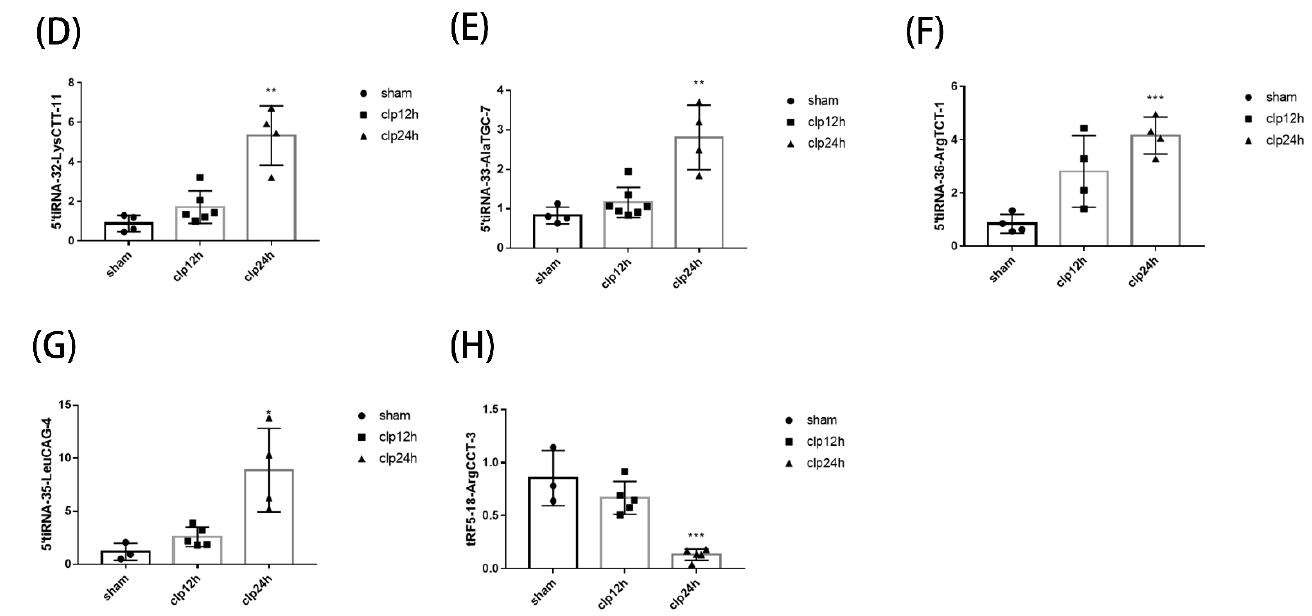
Figure 3. Identification of septic cardiomyopathy-related tsRNAs and qPCR verification. ( A – H ) The qPCR results confirmed that 5 ’ tiRNA-34-AspGTC-2( n = 4 in SHAM group, n = 7 in CLP12h group, n = 3 in CLP 24h group) 、 5 ’ tiRNA-33-CysACA-1( n = 4 in SHAM group, n = 3 in CLP12h group, n = 3 in CLP 24h group) 、 5 ’ tiRNA-33-ProTGG-1( n = 3 in SHAM group, n = 4 in CLP12h group, n = 4 in CLP 24h group) 、 5 ’ tiRNA-32-LysCTT-11( n = 4 in SHAM group, n = 6 in CLP12h group, n = 4 in CLP 24h group) 、 5 ’ tiRNA-33-AlaTGC-7( n = 4 in SHAM group, n = 7 in CLP12h group, n = 4 in CLP 24h group) 、 5 ’ tiRNA-36-ArgTCT-1( n = 4 in SHAM group, n = 4 in CLP12h group, n = 4 in CLP 24h group) 、 5 ’ tiRNA-35-LeuCAG-4( n = 3 in SHAM group, n = 5 in CLP12h group, n = 4 in CLP 24h group) and tRF5-18-ArgCCT-3( n = 4 in SHAM group, n = 5 in CLP12h group, n = 5 in CLP 24h group) were consistent with tsRNA microarray data. Data were presented as mean ± standard deviation. *